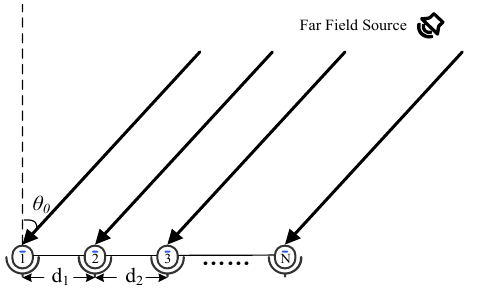
Figure 2. Signal and array model.